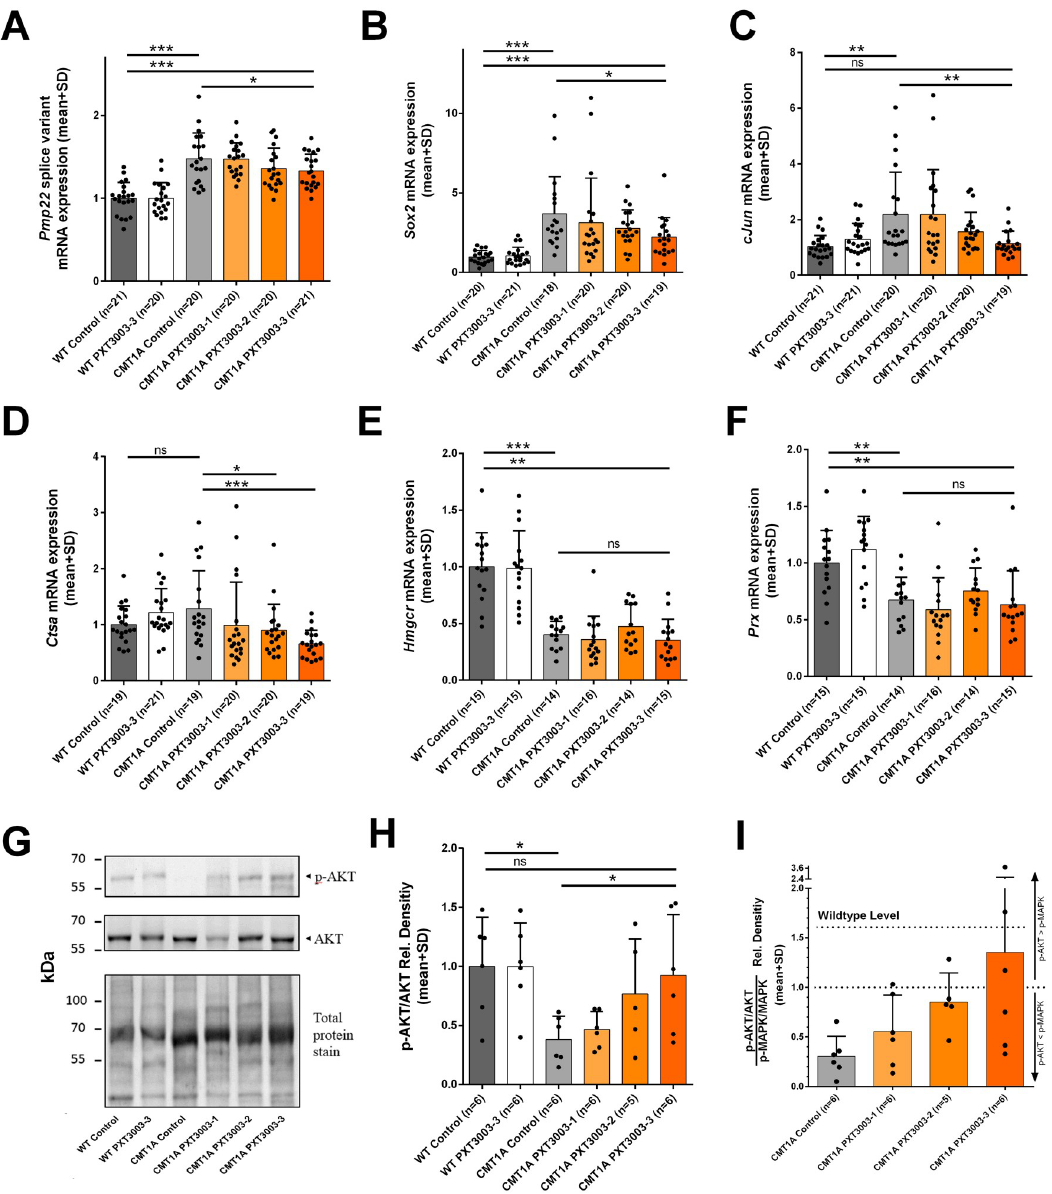
Fig 4. PXT3003 therapy acting on Pmp22 overexpression and downstream signalling in long-term at 12 weeks. Early short-term applied PXT3003 was in long-term effective on the downregulation of disease-causing Pmp22 mRNA overexpression in CMT1A rats in the sciatic nerve (A; WT controls 1.00 ± 0.04, CMT1A controls 1.48 ± 0.07, CMT PXT3003-3 1.33 ± 0.04; Pmp22 splice variant normalised to C yclophilin A) . In the brachial plexus, mRNA expression of the differentiation marker Sox2 (B; WT controls 1.00 ± 0.09, CMT1A controls 3.68 ± 0.55, CMT PXT3003-3 2.22 ± 0.28; normalised to C yclophili n A and Rplp0 ) and cJun (C; WT controls 1.00 ± 0.09, CMT1A controls 2.18 ± 0.34, CMT PXT3003-3 1.14 ± 0.10; normalised to C yclophili n A and Rplp0 ), as well as the biomarker Ctsa were influenced by PXT3003 in long-term observation (D; WT controls 1.00 ± 0.08, CMT1A controls 1.28 ± 0.16, CMT PXT3003-3 0.66 ± 0.06; normalised to C yclophili n A and Rplp0 ). Downregulated Hmgcr and Prx mRNA expression in CMT1A rats were not affected by PXT3003 (E; WT controls 1.00 ± 0.08, CMT1A controls 0.40 ± 0.03, CMT PXT3003-3 0.35 ± 0.05 and F ; WT controls 1.00 ± 0.07, CMT1A controls 0.67 ± 0.05, CMT PXT3003-3 0.63 ± 0.08; normalised to C yclophili n A and Rplp0 ). Pmp22 downstream signalling was investigated by Western Blot analysis using antibodies against p-AKT/AKT and p-MAPK/MAPK (G). At the end of long-term observation, PXT3003 early short-term treatment restored the decreased p-AKT/AKT signalling in CMT1A rats (H; WT controls 1.00 ± 0.17, CMT1A controls 0.38 ± 0.08, CMT PXT3003-3 0.93 ± 0.21) and dose-dependently corrected the disrupted ratio of p-AKT/AKT to p-MAPK/MAPK signalling towards the wildtype situation (I; CMT1A controls 0.30 ± 0.08, CMT PXT3003-1 0.56 ± 0.15, CMT PXT3003-2 0.85 ± 0.13, CMT PXT3003-3 1.36 ± 0.52), which is characterized by a higher relative amount of p-AKT versus p-MAPK. (ns = not significant, � = p < 0.05, �� p < 0.01 and ��� = p <